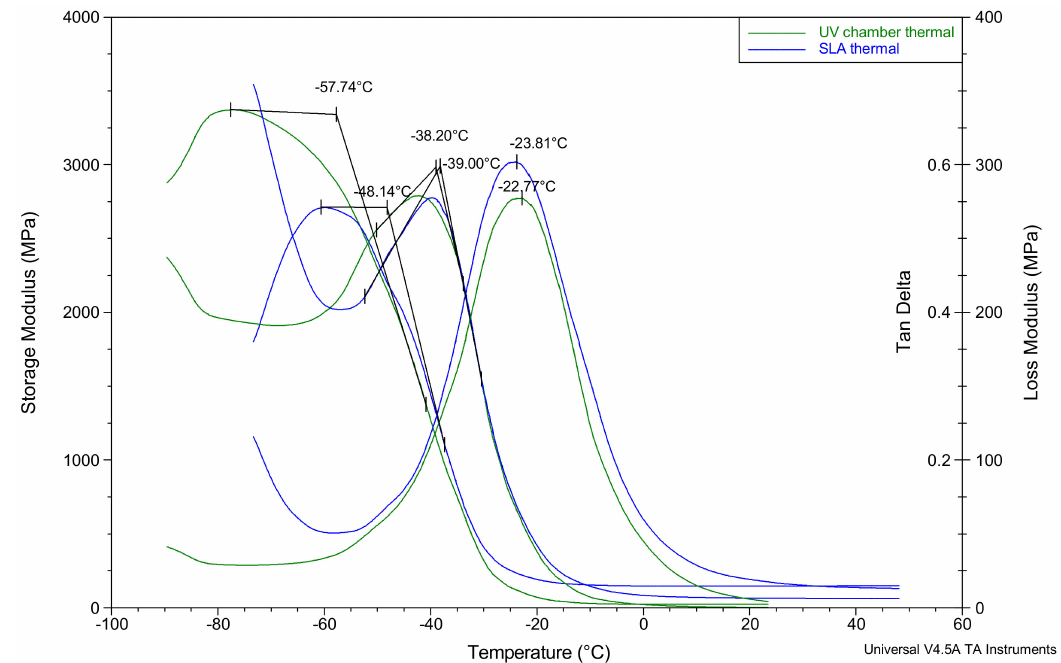
Figure 4. Dynamic mechanical analysis results showing the storage modulus (G’), the loss modulus (G”) and the tan delta for both PEGDMA samples prepared via UV chamber and PEGDMA hydrogels prepared by SLA.